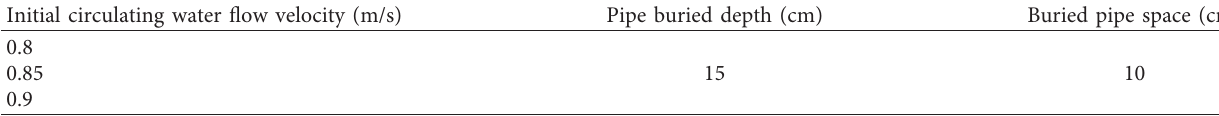
Table 2: Design of flow velocity working conditions.